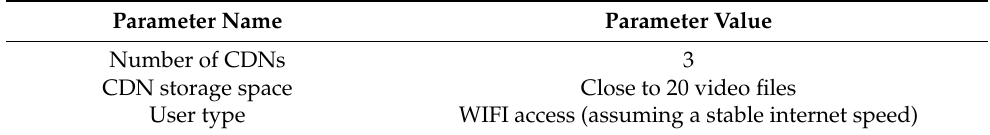
Table 3. Table of the simulated networking parameters.